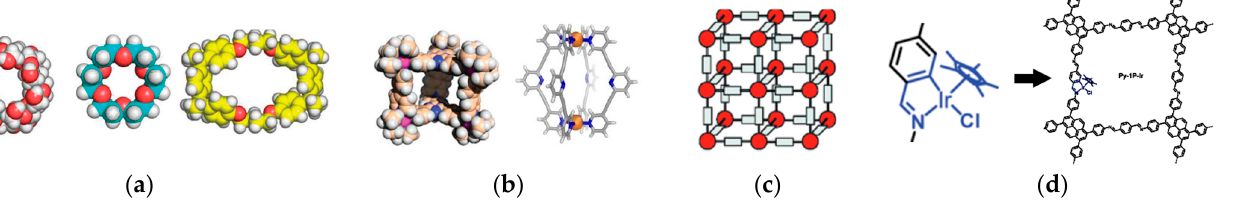
Figure 2. Diversity of cavitins. Discrete cavitins: ( a ) cyclodextrin, crown ether, cyclophane, and ( b ) metal-coordination cages. Extended cavitins: (c) MOF and ( d ) COF, the arrow symbolizes the incor-